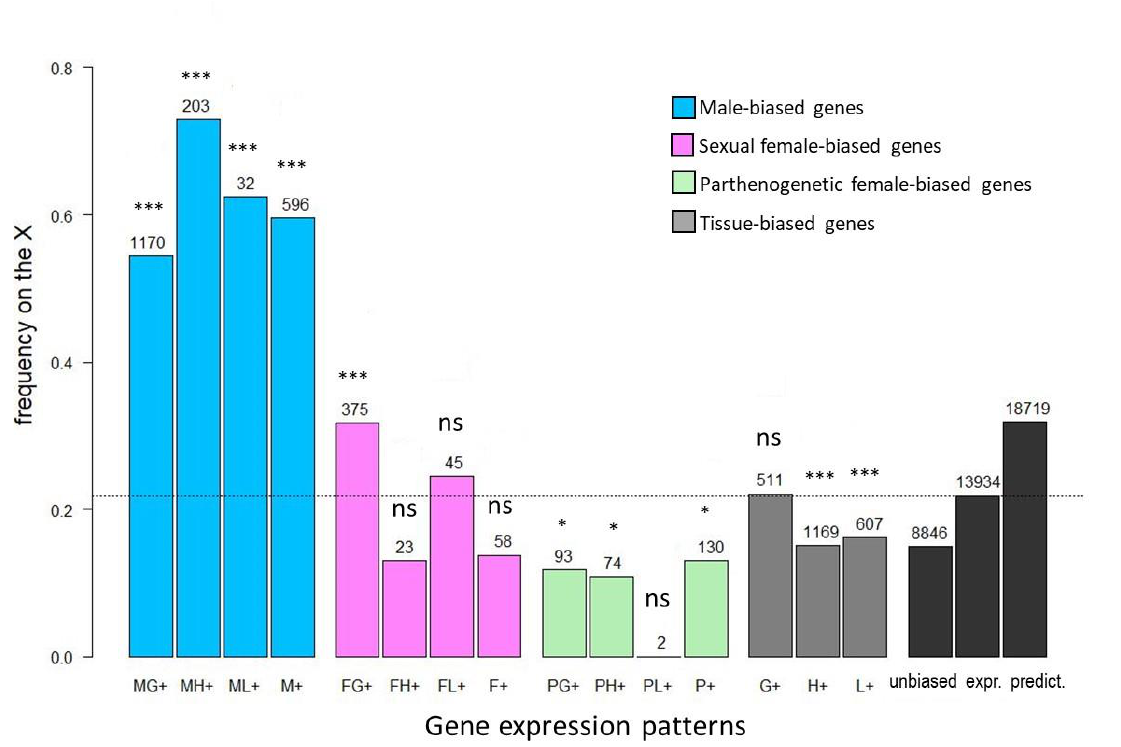
Figure 2: Proportions of X-linked genes among genes preferentially expressed in various morphs and/or tissues. Blue bars represent male-biased genes; MG+, MH+ and ML+: genes expressed preferentially in male gonads, heads and legs, respectively. M+: genes preferentially expressed in males when pooling all tissues, excluding the genes assigned to the previous categories. Pink bars represent sexual female-biased genes, with F standing for females and letters G, H and L having the same meaning as in males. Green bars represent parthenogenetic female-biased genes (P). Grey bars represent genes expressed preferentially in one of the tissues (gonads, heads or legs) and not limited to a particular morph. Black bars represent the frequency of X-linked genes among genes with unbiased expression (“unbiased”), genes expressed with CPM > 1 in at least two libraries (“expr.”) or all predicted genes (“predict.”). The horizontal dotted line represents the proportion of X-linked gene among expressed genes. The number of genes from each category is shown above bars, as well as the p-value (two-sided binomial tests against the expected frequency on the X chromosome estimated from expressed genes, which corresponds to the dotted horizontal black line). ***: p < 0.001; **: p < 0.01; *: p < 0.05; ns: p ≥